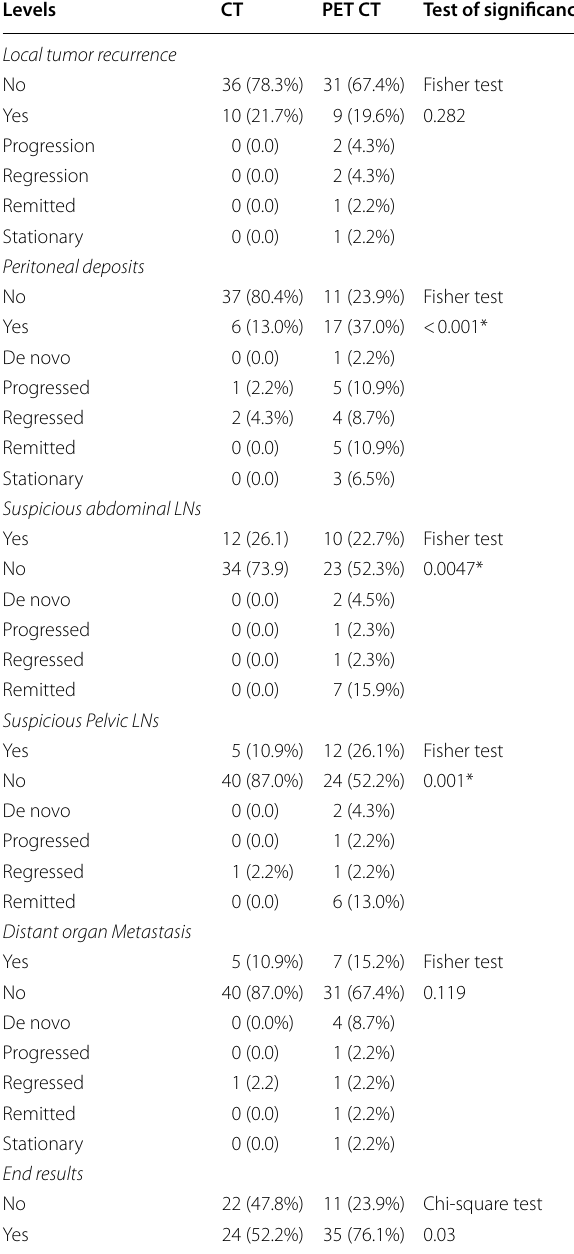
Table 6 Comparison between CT and PET/CT between 1st and 2nd follow‑up cases regarding local recurrence and distant metastasis: Levels CT PET CT Test of